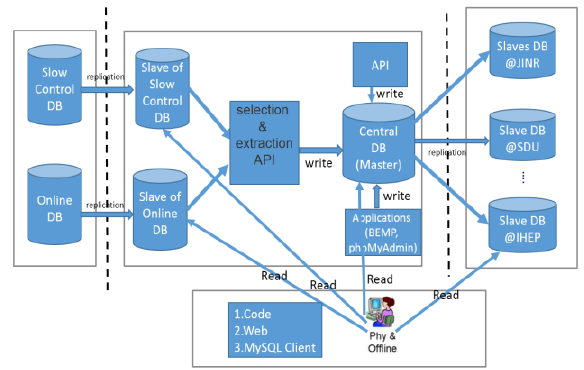
Fig. 3. The BESIII Central Database System